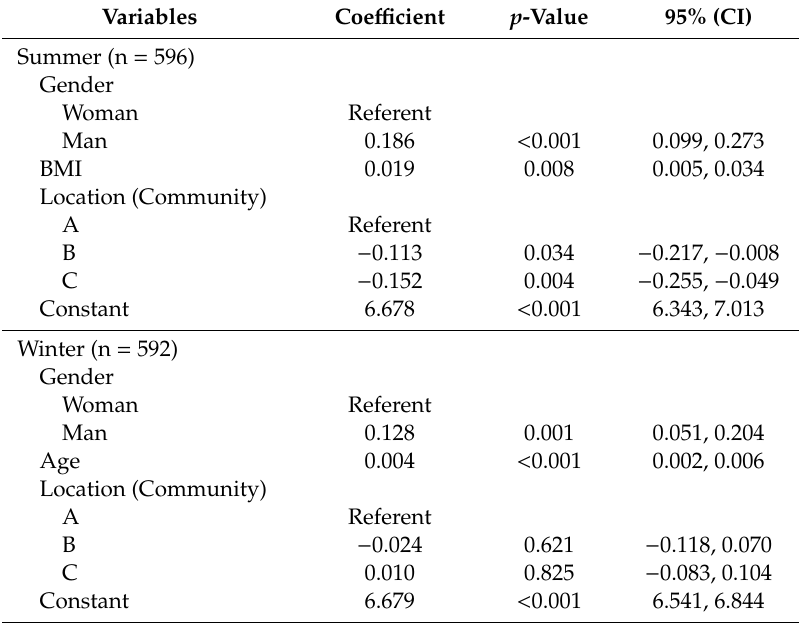
Table 3. Impacts of demographic variables on the water consumption of the adults in summer and winter in multivariate